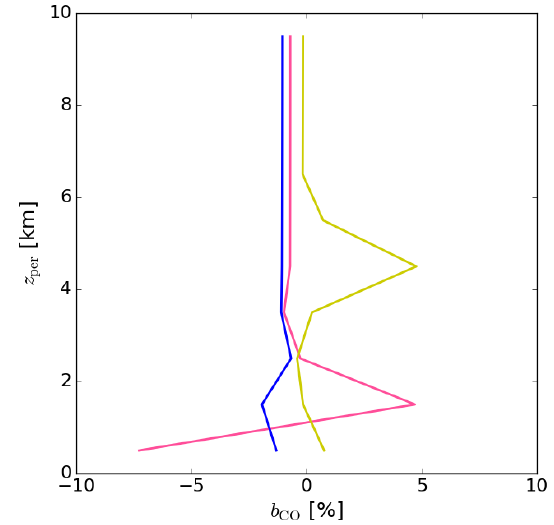
Figure 7. Retrieval bias b CO in cloudy atmospheres in case of strongly enhanced CO concentrations. Measurement simulations are performed for a surface albedo A s = 0 . 05, SZA and VZA of 50 and 0 ◦ and for overcast sky with a cloud at 1–2km altitude with an optical depth of τ cld = 2 (pink) and τ cld = 5 (blue). Addition- ally, we consider a case of partially cloud cover with cloud fraction f cld = 0 . 1 at 4–5km altitude with τ cld = 2 (yellow). The CO profile represents the US Standard Atmosphere with a perturbation at the indicated altitude z per enhancing the total amount of CO by